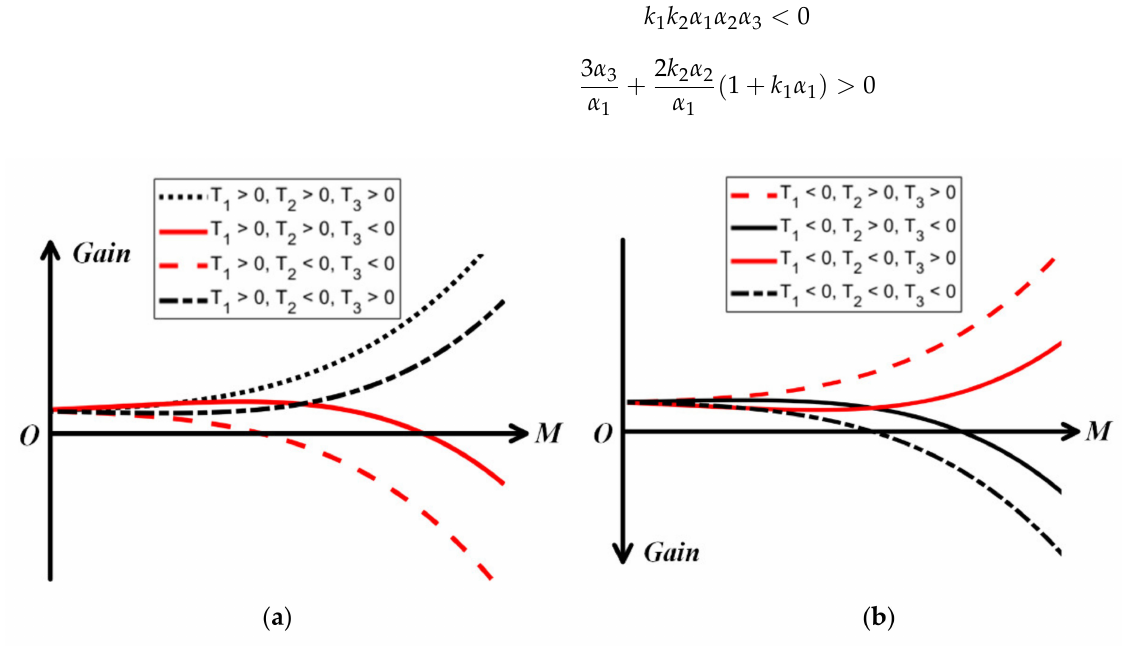
Figure 2. Different trends of Gain. ( a ) T 1 > 0, ( b ) T 1 <